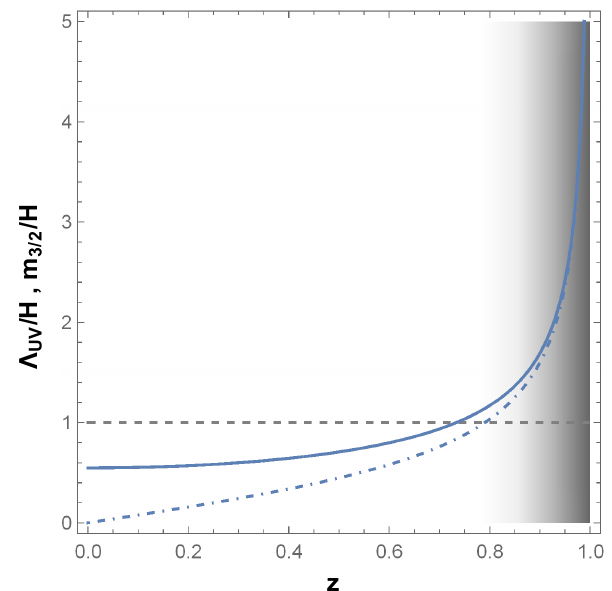
Figure 2 . The ratios Λ UV /H (solid) and m /H (dot-dashed) as a function of the modulus 3 / 2 z = Im z 2 in the SU(2) × O(1,1) model. For small values of z the gravitino mass vanishes and the Hubble scale is above the cut-off, so the theory has a Dine-Seiberg problem. The shaded gray region denotes where the effective theory is increasingly well controlled; in the dark gray part H (cid:28) Λ UV . The gravitino mass is always below the cut-off, approaching it as z approaches the boundary of moduli